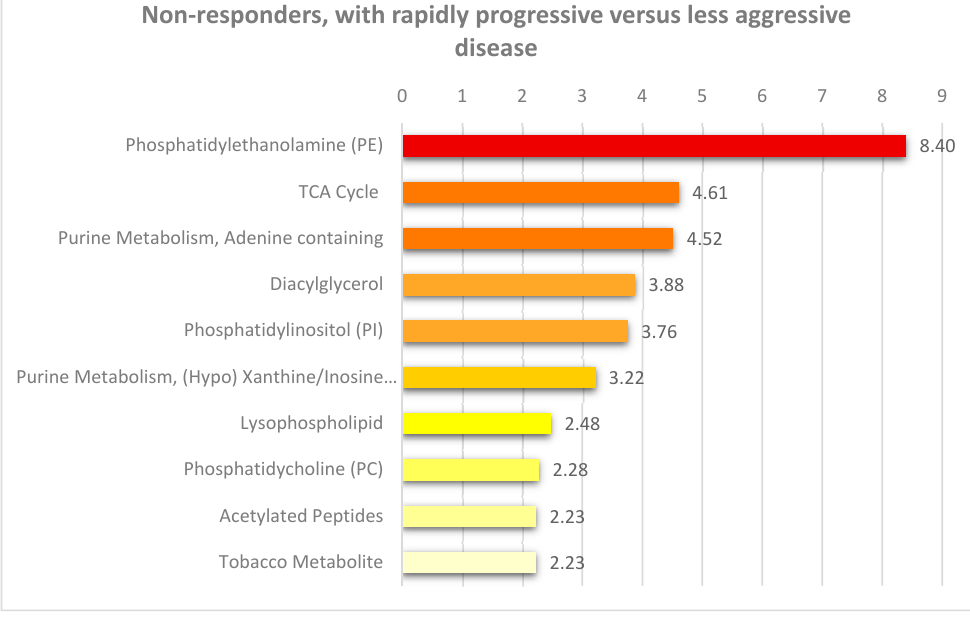
Figure 3. Pathway enrichment analysis based on altered metabolites between non-responder patients with rapidly progressive disease (i.e., aggressive disease) versus non-responders with less aggressive disease. This analysis was based on significantly altered metabolites p < 0.05 (see Figure 1). Only pathways with an enrichment value greater than two and at least two metabolites within each pathway are shown in the figure.